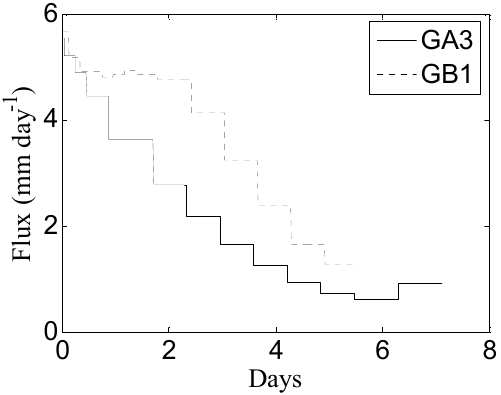
Figure 1. Evaporation flux at the soil surface calculated from the water balance of each soil sample between consecutive measure- ments of the soil